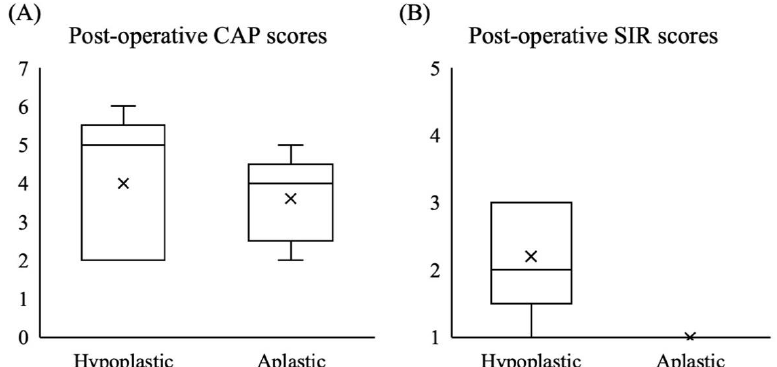
Figure 3. Comparison of the cochlear implantation outcomes in patients with hypoplastic and aplas- tic cochlear nerves. ( A ) The postoperative Categories of Auditory Performance (CAP) scores were similar between the two groups. ( B ) The postoperative Speech Intelligibility Rating (SIR) scores were significantly better in patients with hypoplastic cochlear nerves than those with aplastic cochlear nerves.